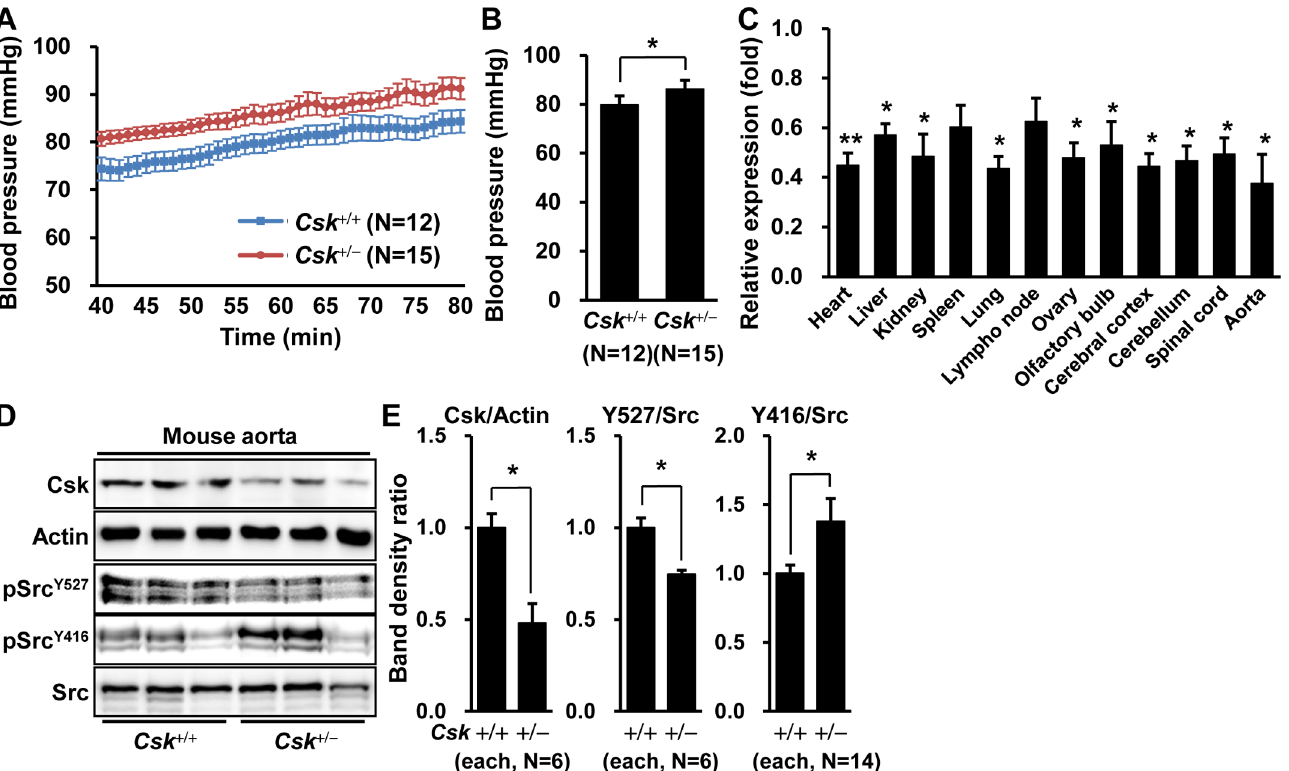
Fig 4. Increase in blood pressure in Csk +/- mice. (A, and B) Blood pressure is expressed as (A) the average value at each minute and (B) the mean blood pressure for each group from 40 min to 80 min after anesthesia in Csk +/- and the wild-type. (C) The relative expression of Csk mRNA in each tissue is expressed as the fold change of relative levels in Csk +/- (N = 7) versus Csk +/+ (N = 5), normalized by Gapdh . (D) The representative blots of Csk and phosphorylated Src protein levels are shown following Western blotting in aorta of Csk +/- and Csk +/+ mice. (E) Protein levels in aorta are presented as the ratio of band densities for Csk +/- mice to those for Csk +/- . Number in parentheses indicates the number of mice used for the Western